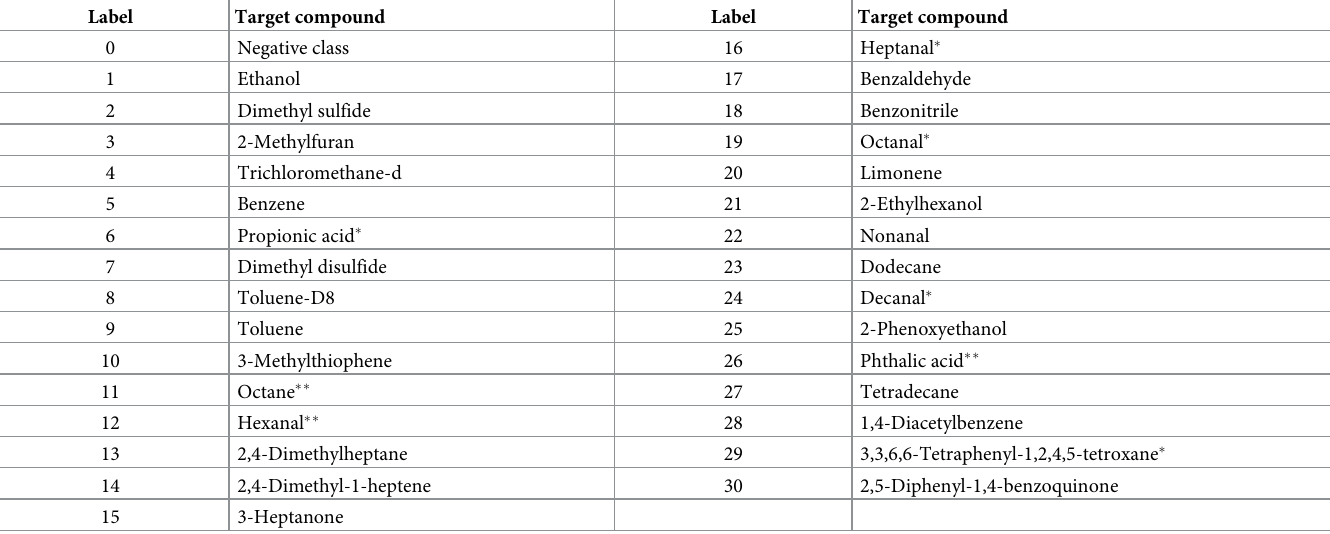
The frames indicate pairs of overlapping compounds. Compounds of relatively low concentrations are marked with � and �� : Mean EIC-Area � � 10 3 � Mean EIC-Area �� � Q 1 (first quartile); see S1 Table in S1